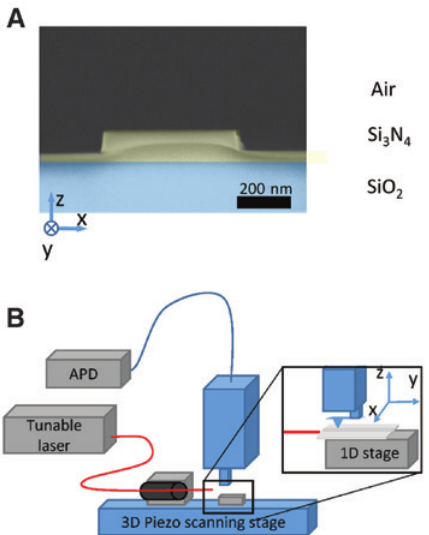
Figure 1: (A) Edge-on scanning electron microscope image of a 650- nm-wide Si N waveguide on substrate (false colored). (B) Schematic 3 4 of the NSOM with 3-D fiber alignment stage for coupling the optical source to the on-chip